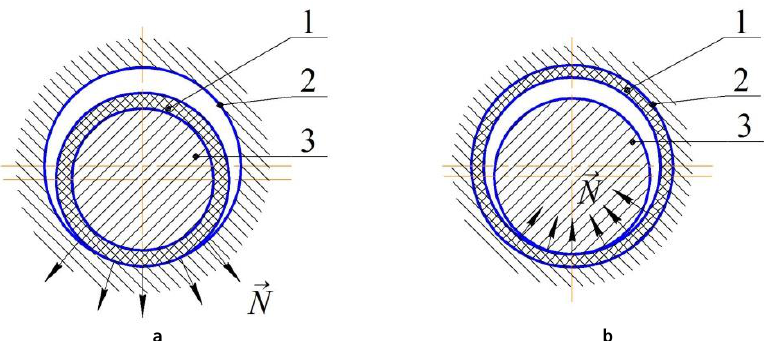
Fig. 2. Schemes of reverse (a) and forward (b) tribocoupling of parts: 1 – layer of PC or PCC; 2 – sleeve; 3 - shaft. The displayed different nature of force influence in the reverse and forward tribocouplers determines the difference in the conditions of their friction and wear. This is evidenced by the analysis of the operation of "shaft- hub" couplings, characteristic of seeders [1,2] and other machines [ 16-21 ] .